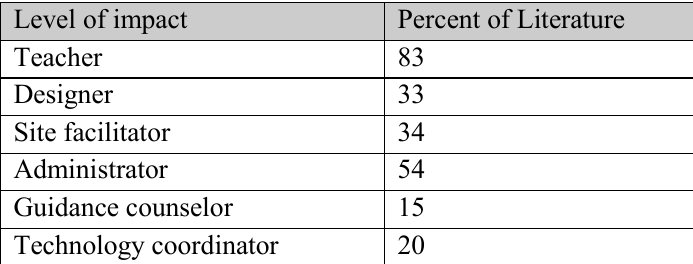
Percentage of Literature about Various Levels of Impact Level of